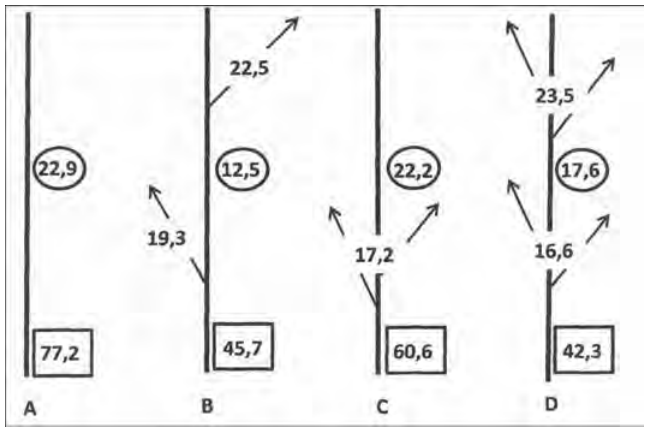
Fig. 20 - Fruit- shoot correlative relationships on peach one-year-old mixed shoots 0.2 m long. (Circles = fruit; arrows = shoots; square = basal leaf of mixed shoot treated with 14C, all other organs were removed). The organ (or organs) at the higher position was always the strongest sink. The fruit was a very strong sink (situation A); when the fruit was in between two shoots its strength was strongly reduced (situation B); when the fruit was above two shoots it was dominant (situation C) and therefore the relative organ position changed the sink re- lationship; the number of shoots above and below the fruit change the relationship between the organs (situations B and D). (Giulivo and Ramina,